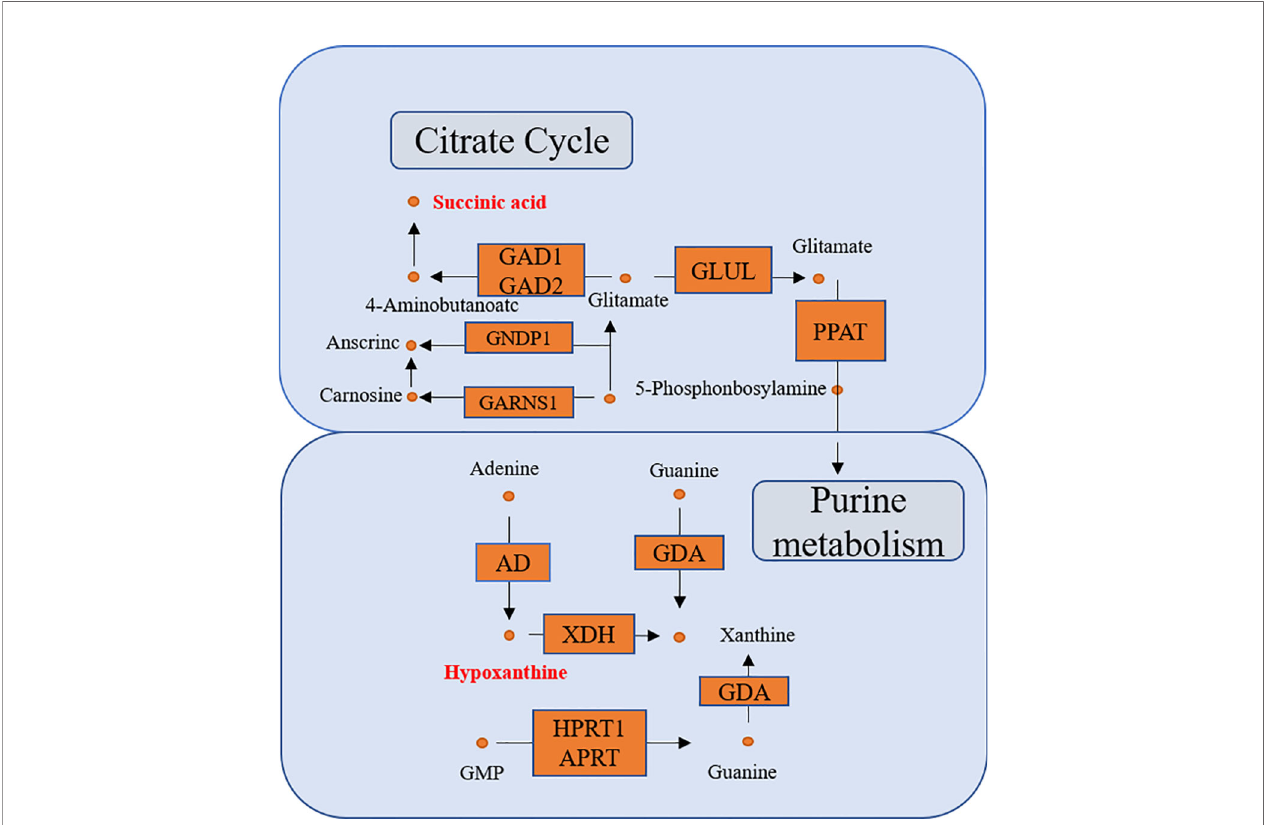
FIGURE 8 | The connectednetwork of genes, enzymes, and metabolites. The orange rectangles and circles represent the signi fi cant genes and metabolites,